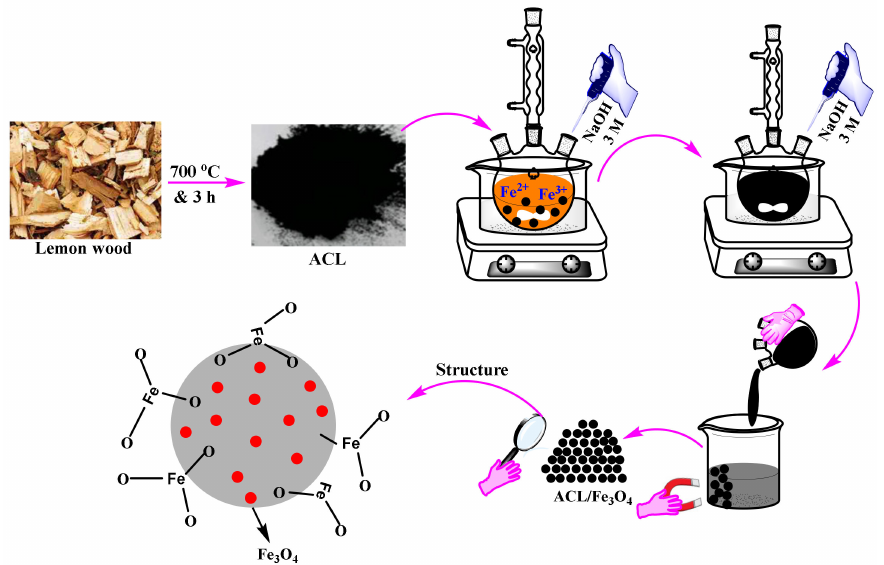
Figure 9. A schematic illustration of the productions process and structure of ACL/Fe 3 O 4 magnetic